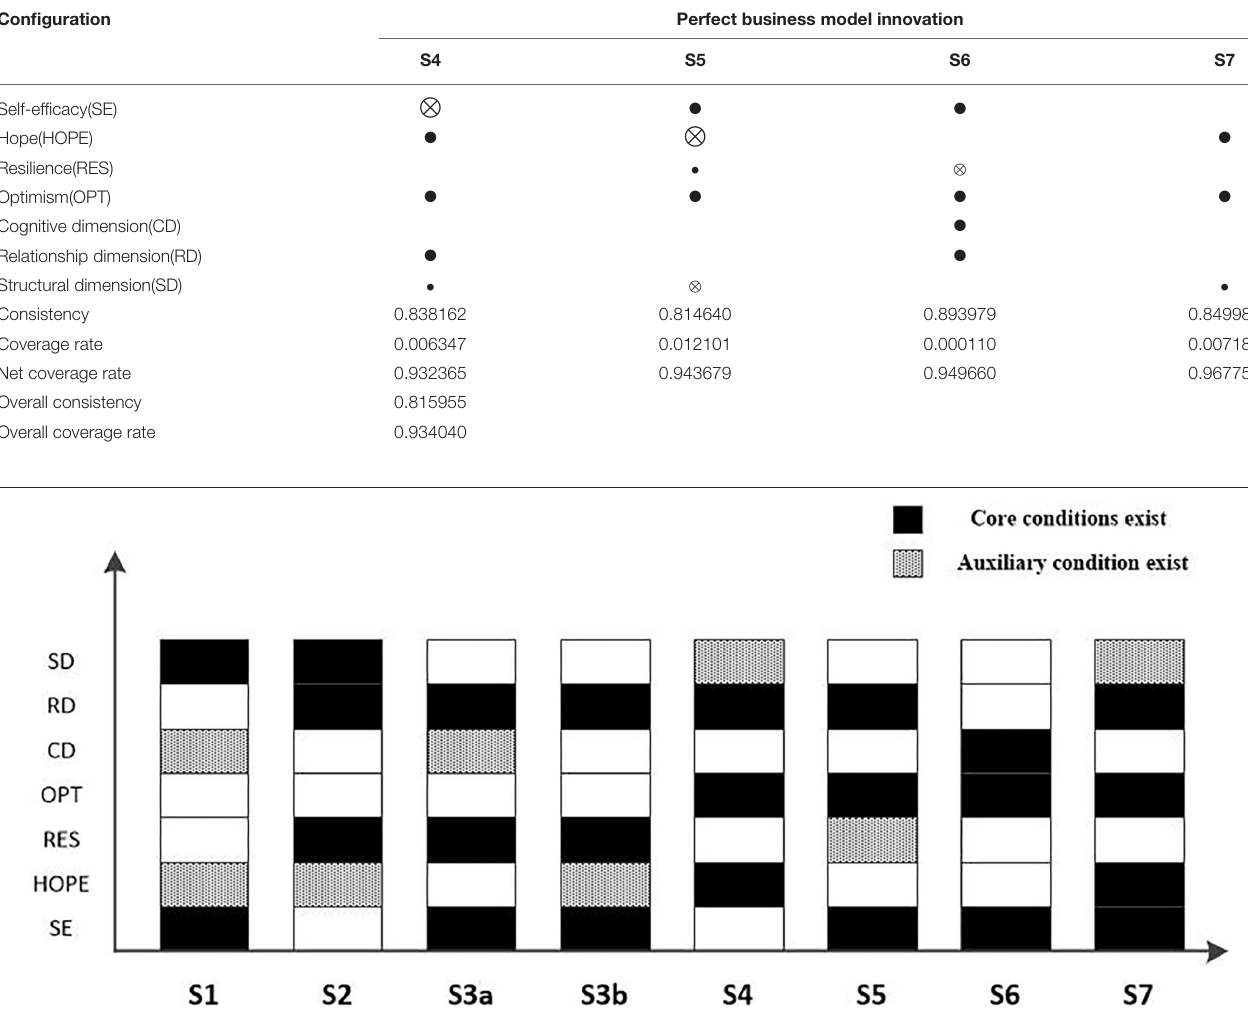
FIGURE 2 | Pre-innovation configuration mode of business model of new